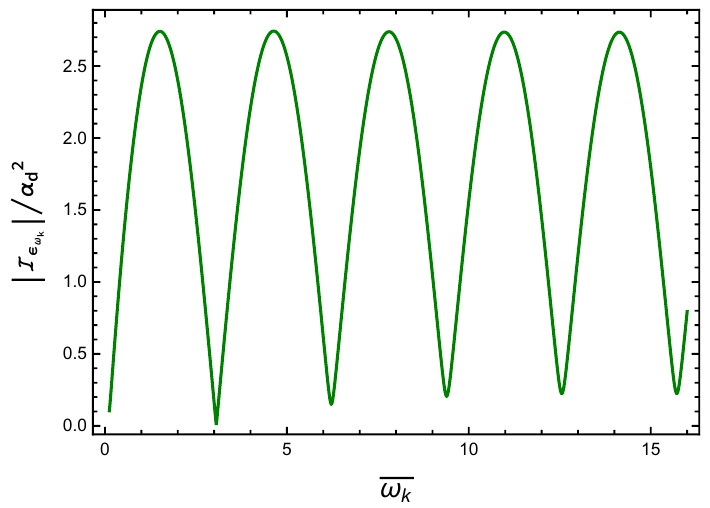
is plotted for two outgoing null detectors in a (1+1) dimensional Figure 13 . The quantity |I ε | /α 2 d ω k de Sitter spacetime with respect to the dimensionless frequency of the field ω and d/α = 1 d